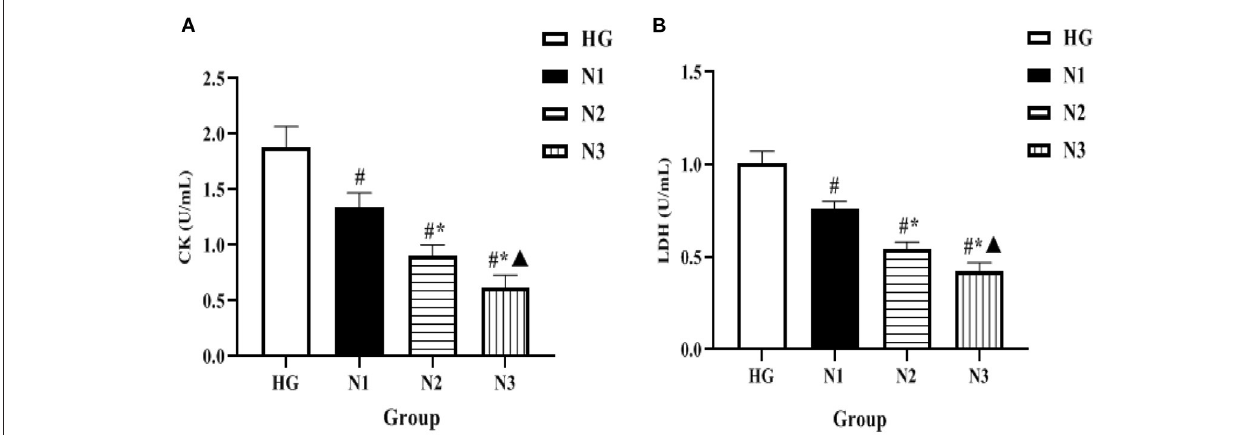
FIGURE 1 | Comparison of enzyme activity levels in H9c2 cells in each group. In the above figure, (A) the comparison of CK levels in the four groups of H9c2 cells, and (B) the comparison of LDH levels in the four groups. Compared with HG group, # P < 0.05; compared with N1 group, * P < 0.05; compared with N2 group, N P < 0.05.